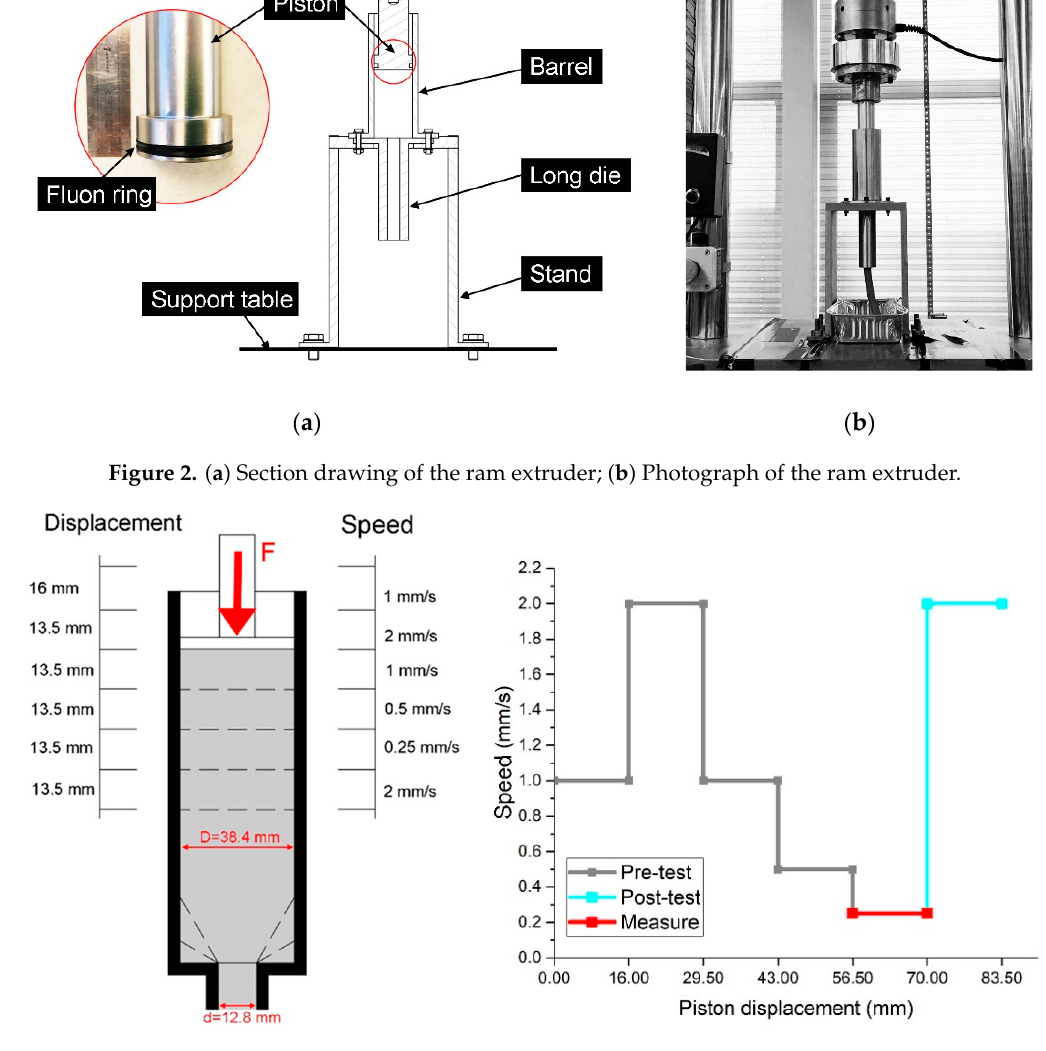
Figure 3. ( a ) Diagram of the extrusion process controlled by the actuator; ( b ) Predefined speed and displacement for the extrusion test.